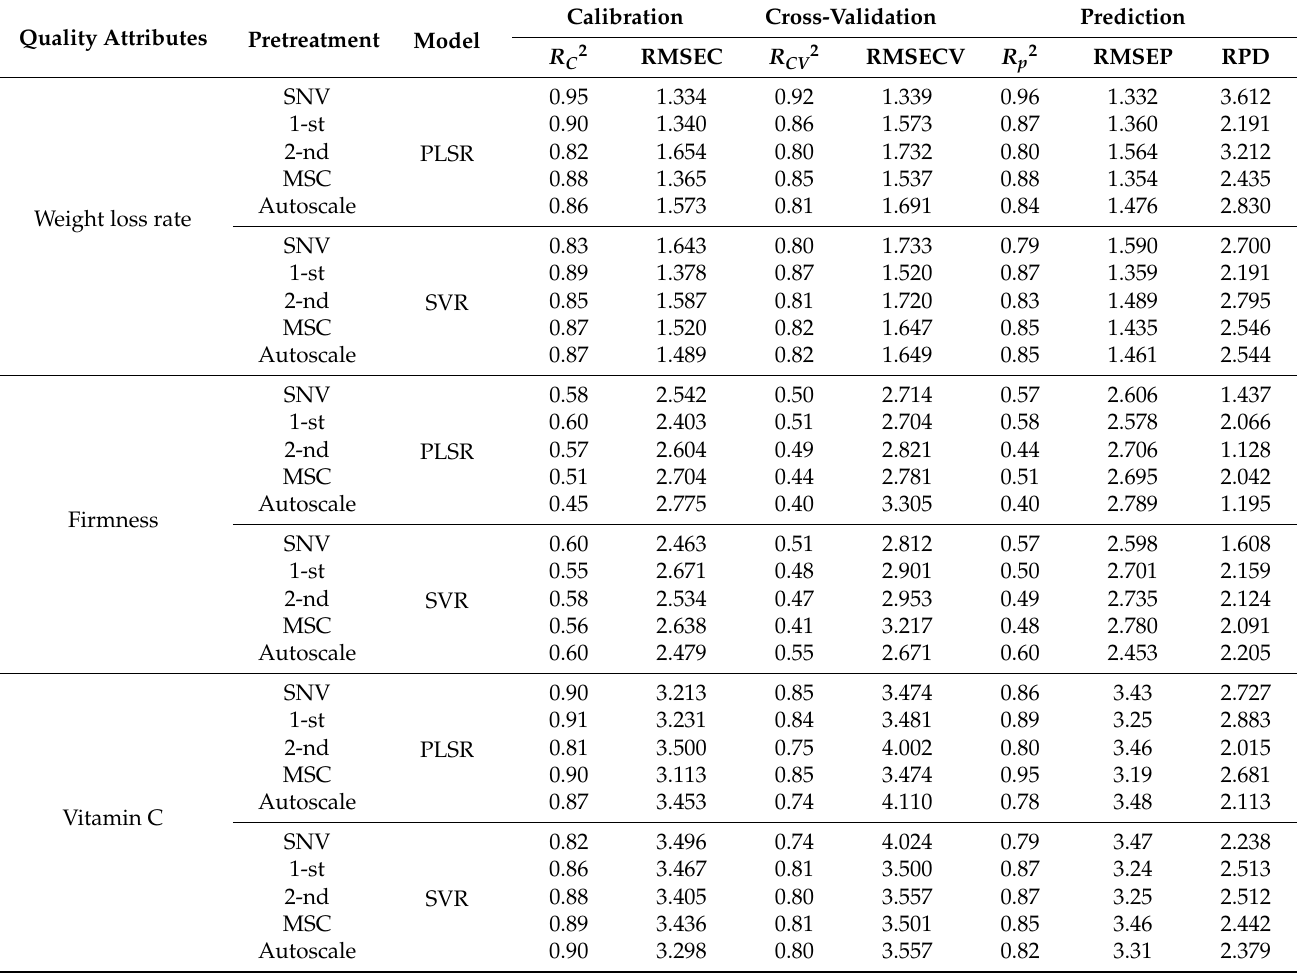
Table 2. Performance of the regression models for weight loss ratio, firmness and vitamin C content of individual mini- Chinese cabbages.